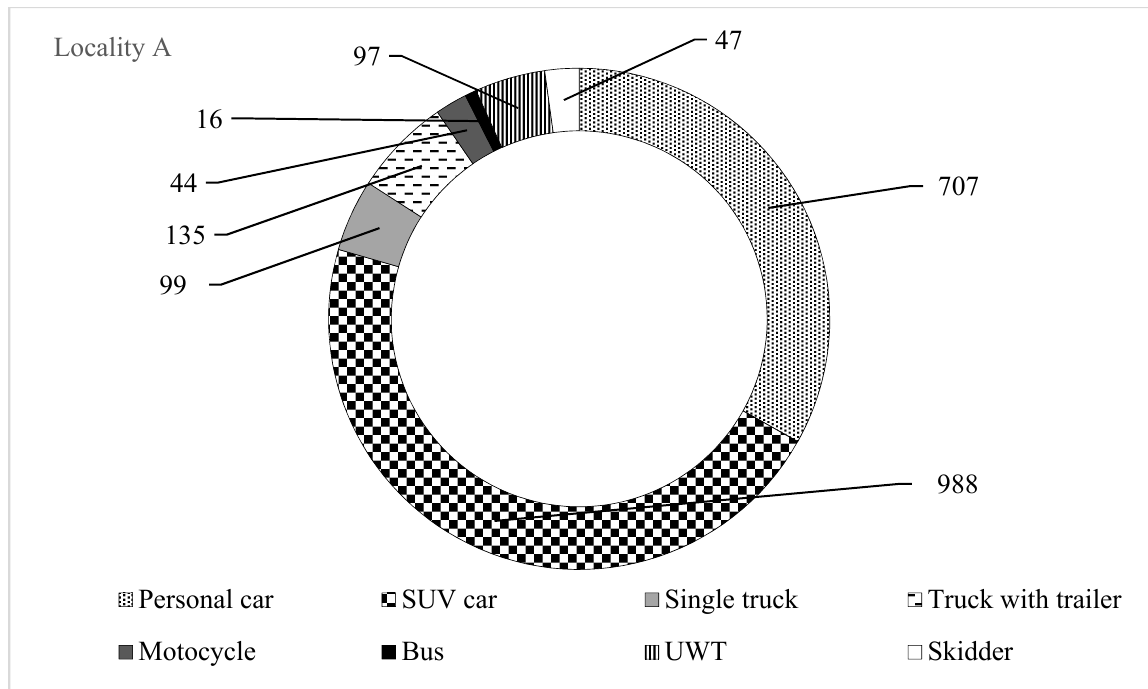
Figure 6. Absolute and relative frequencies of passages of individual vehicle types at A locality in